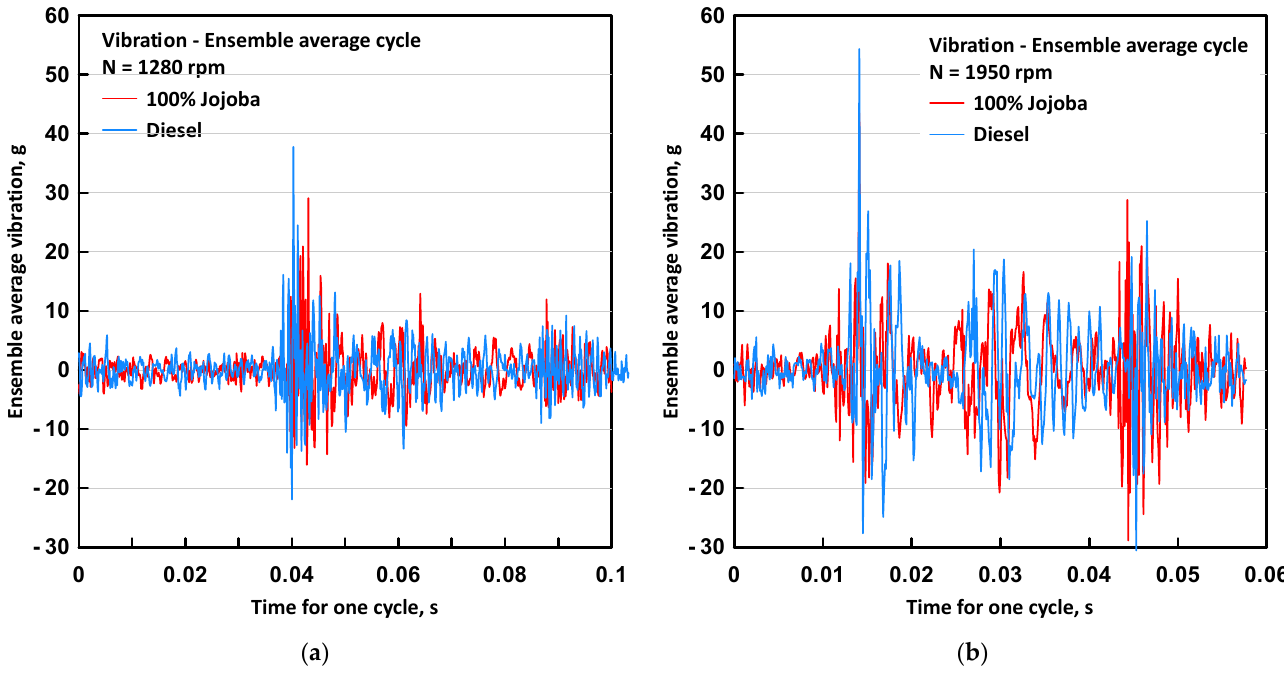
Figure 15. Ensemble-averaged vibration cycle at two engine speeds of ( a ) 1280 rpm and ( b ) 1950 rpm for the two fuels used.